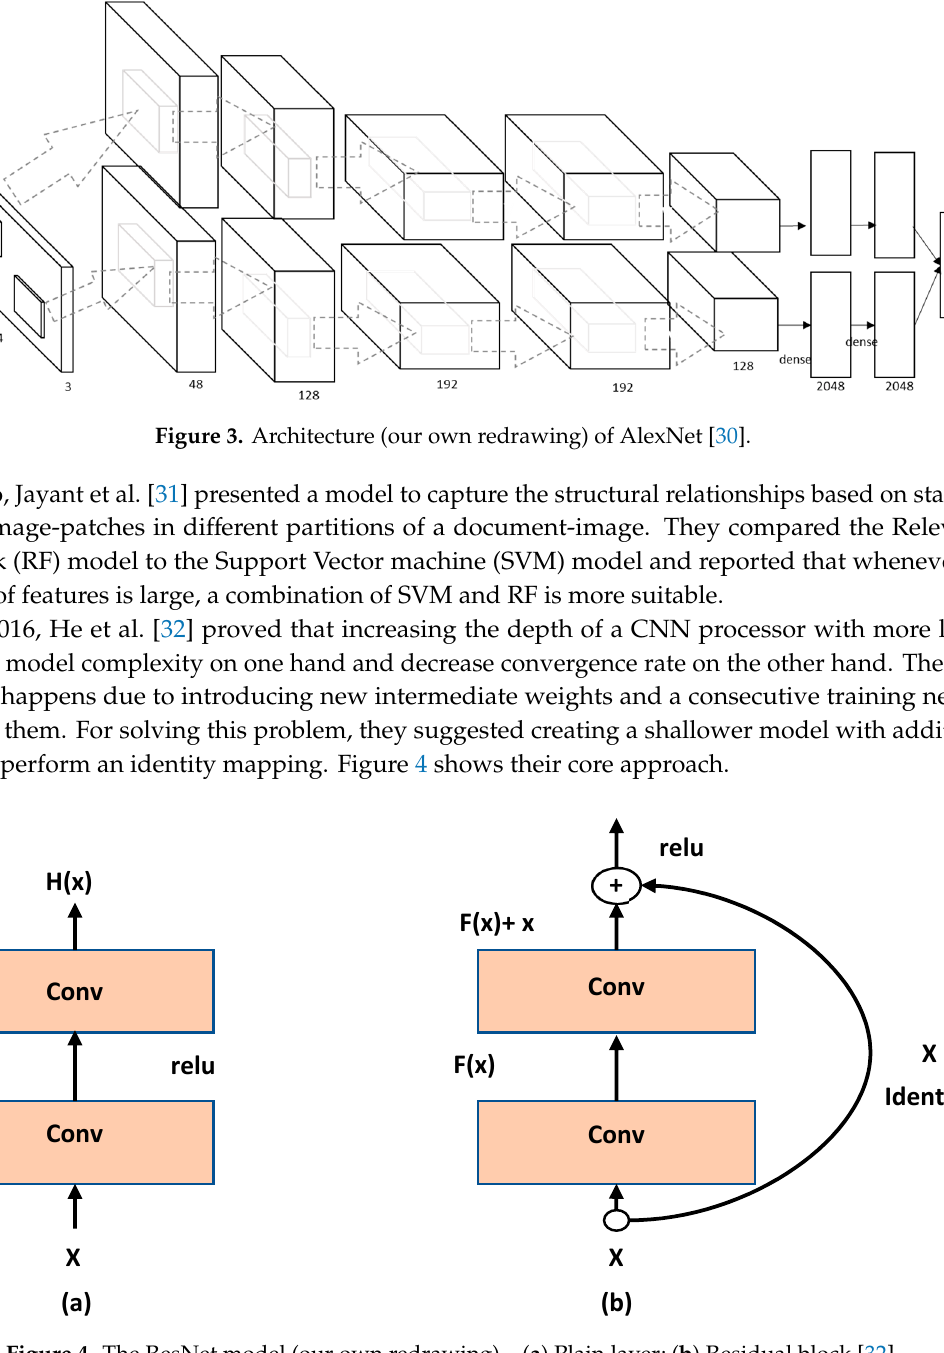
Figure 4. The ResNet model (our own redrawing)—( a ) Plain layer; ( b ) Residual block [32]. The H(cid:4666)x(cid:4667) block is defined as H(cid:4666)x(cid:4667) (cid:3404) F(cid:4666)x(cid:4667) (cid:3397) x . Therefore, F(cid:4666)x(cid:4667) (cid:3397) x will be encapsulated as one block H(cid:4666)x(cid:4667) and the internal complexity of this block shall be hidden. This model is called ResNet and